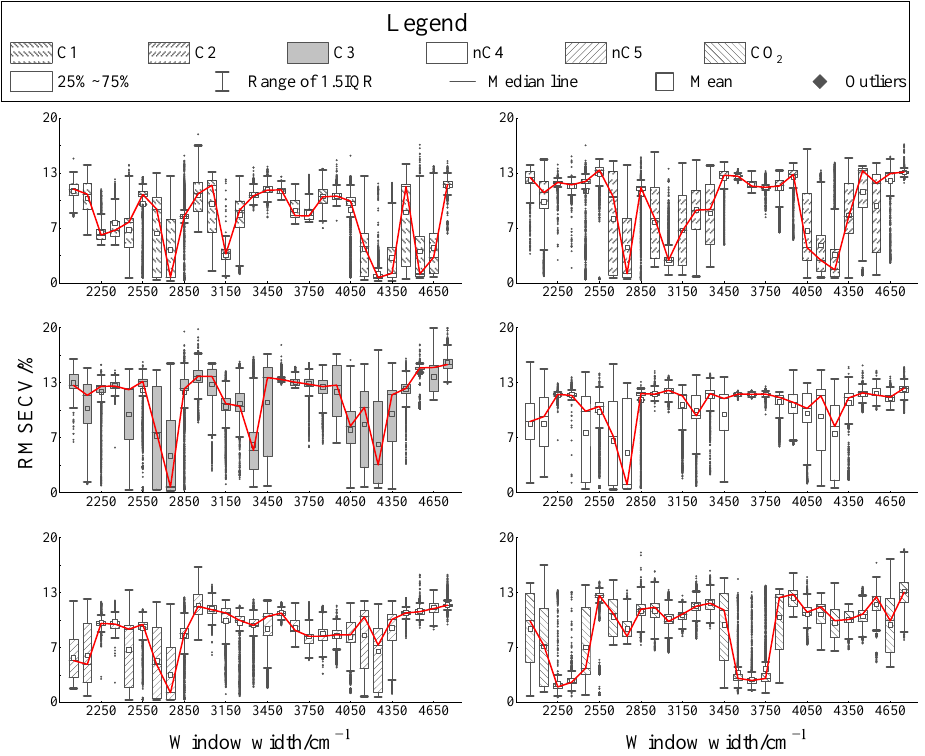
Figure 8. The influence of the local modelling position on the quantitative analysis model of six substances. The statistics include the range of 25% to 75%, the range of 1.5 times the interquartile range (1.5 IQR), the median, mean value and abnormal value